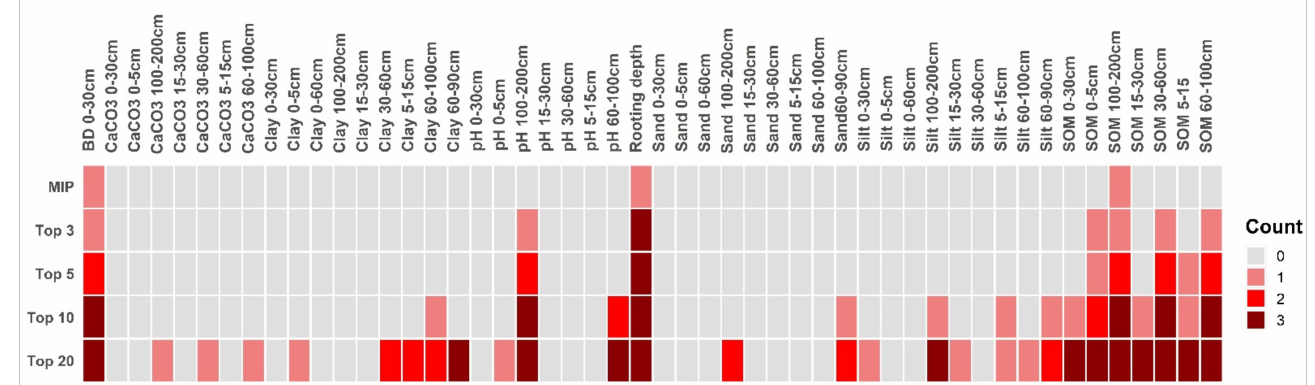
Figure 6. Importance of soil property covariates for predicting the indicators of CMPs and nCMPs. Abbreviations: BD: bulk density, SOM: soil organic matter content.